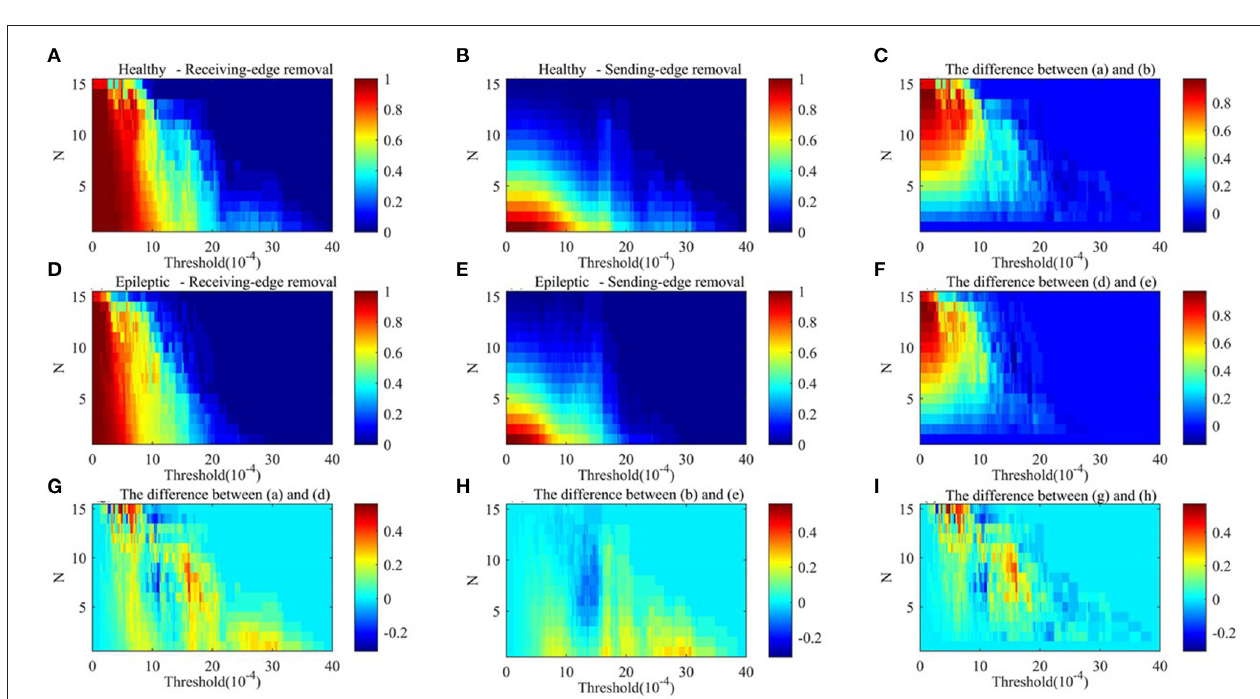
FIGURE 9 | The average clustering coefficient of residual networks in alpha rhythm. (A) Healthy sample brain networks based on receiving-edge removal. (B) Healthy sample brain networks based on sending-edge removal. (C) The difference between (A) and (B) . (D) Epileptic sample brain networks based on receiving-edge removal. (E) Epileptic sample brain networks based on sending-edge removal. (F) The difference between (D) and (E) . (G) The difference between (A) and (D) . (H) The difference between (B) and (E) . (I) The difference between (C) and (F) .